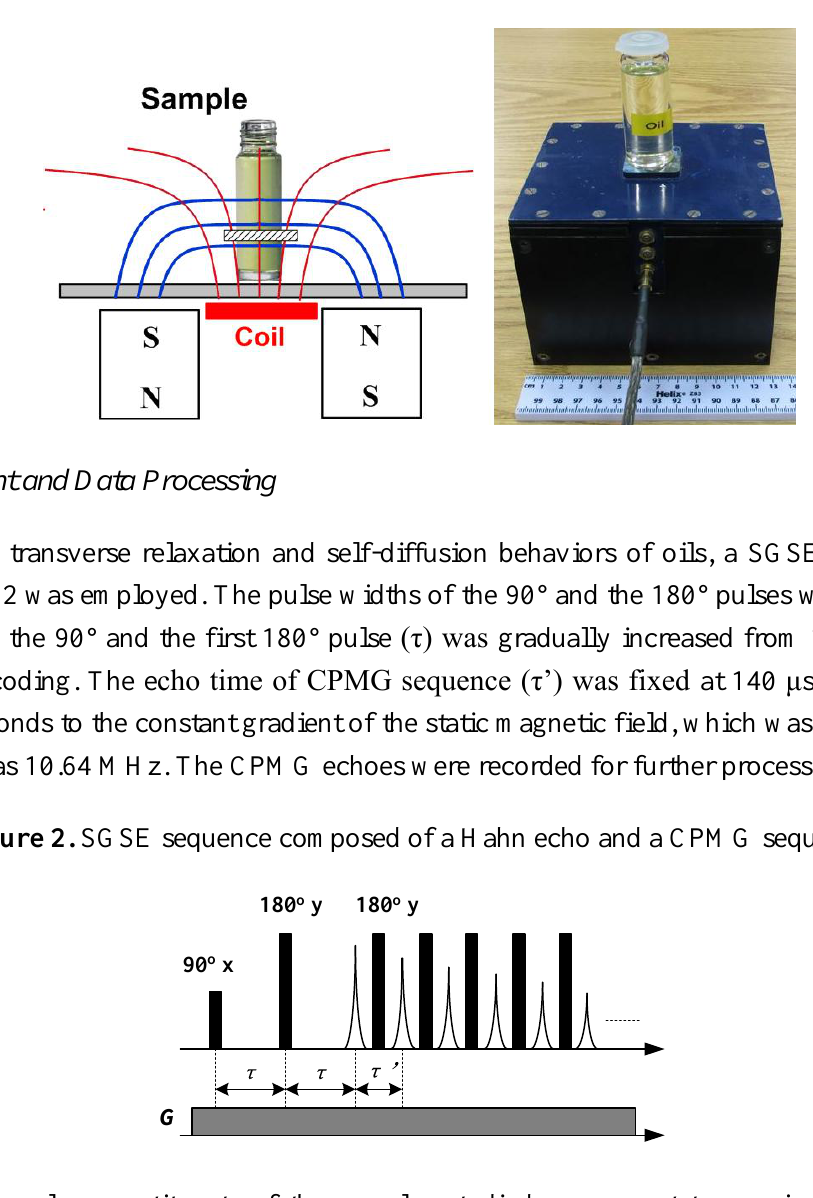
Figure 1. Schematic diagram of the NMR MOUSE with the sample and the selective slice shown.